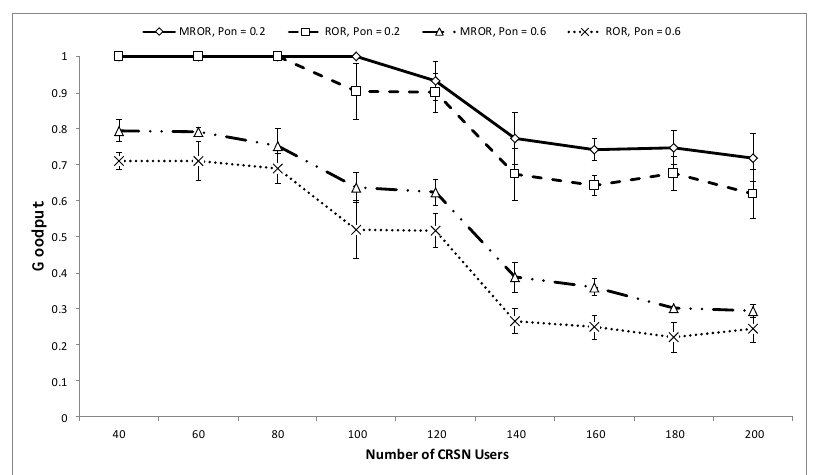
Figure 14. Goodput vs . number of network nodes.